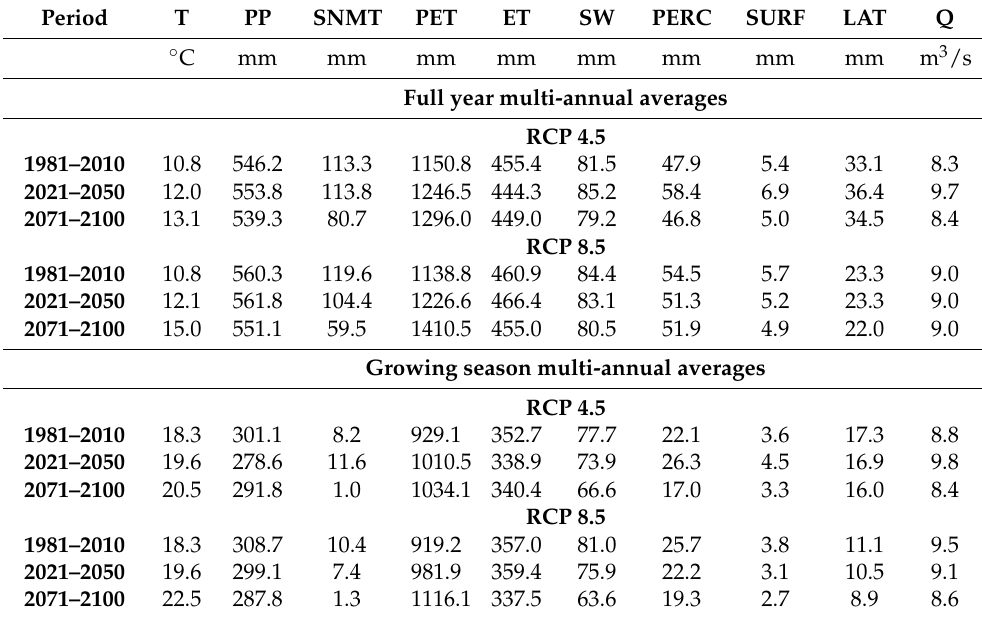
Table 4. Average values for the main water balance components for the reference, short- and long- term periods (catchment scale) 1